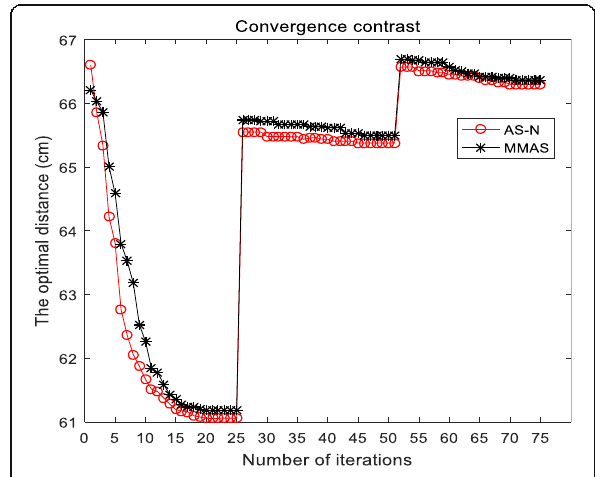
Fig. 11 Complex environment 2 convergence chart